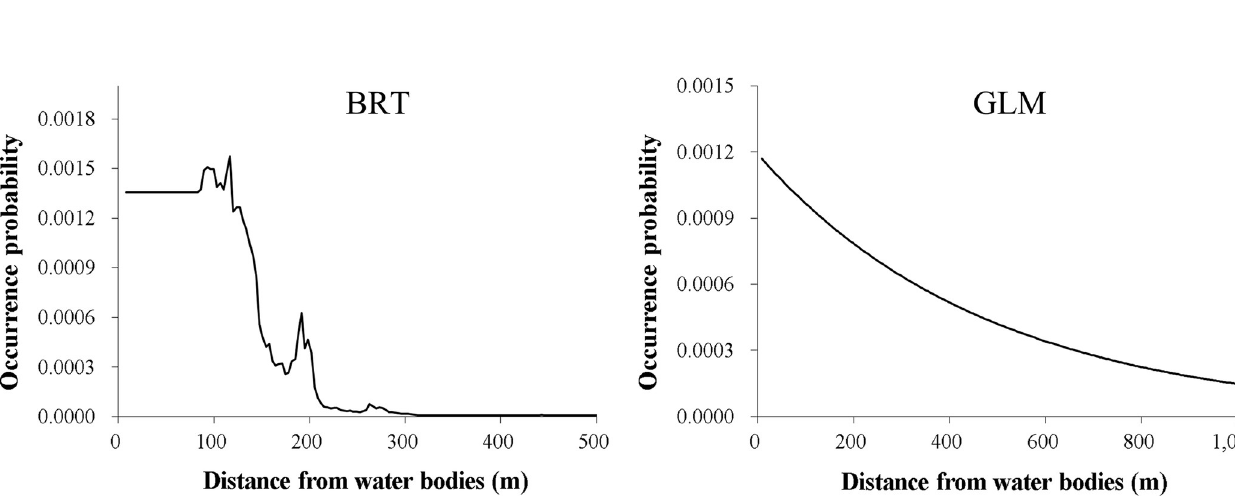
PLOS ONE | https://doi.org/10.1371/journal.pone.0279082 December16,